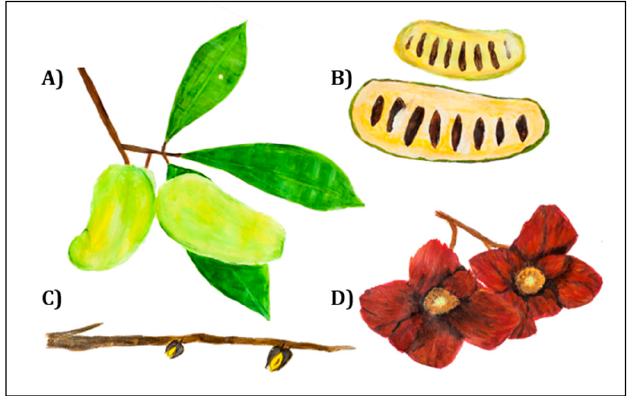
Fig. 1: Artists rendition of the parts of the pawpaw ( Asimina triloba ) plant. A) Mature fruit on the tree; B) mature fruit cut lengthwise to expose the seeds; C) branch with bud; D) blossom. (Artwork © by author M.N.